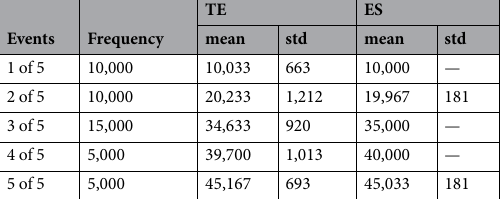
Figure 8(a,b) illustrates the behaviour of the cumulative influence index for each particle for both transfer entropy and directed event synchronization with leaders cumulative influence index increasing while followers index decreases. This behaviour is observed for all 30 sample datasets simulated. Figure 8(c,d) depicts the time trace of the leadership index for a group of N = 10 particles including a switching event after 10,000 time steps. In the Figure, followers leadership index is monotonic decreasing while it reaches a maximum (resp. minimum) for individuals whose state change from leader to follower (resp. follower to leader). The method predictive perfor- mance given by the TPR and the FPR is 0.99 and 0.1 respectively for transfer entropy with a predicted switching time of 10,000 ± 68-time steps. For even synchronization, the TPR and the FPR are 0.98 and 0.13 respectively with the switching time predicted at 9,870 ± 778-time steps.